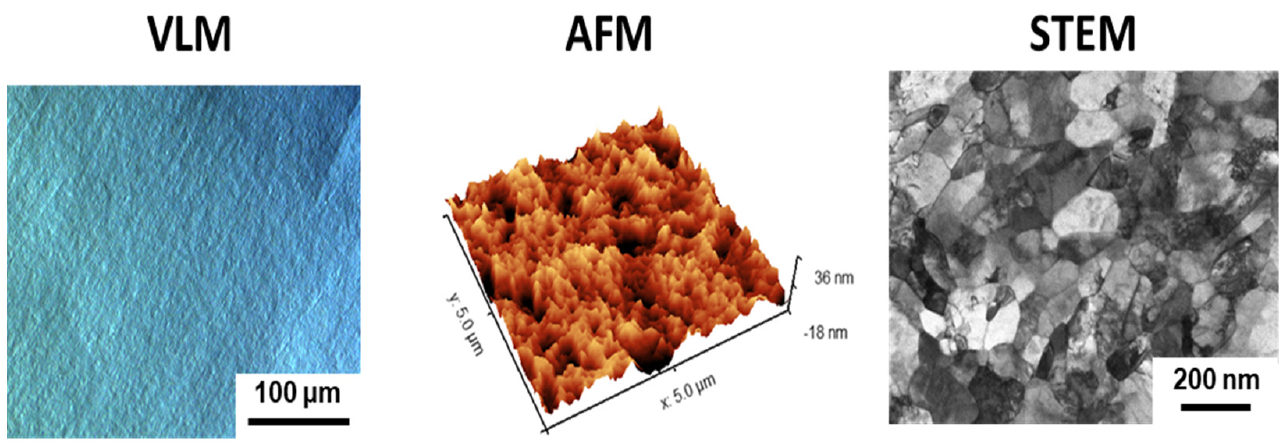
Figure 1. Evaluation of nanostructured Ti surface topography (VLM micrograph and AFM map) origins from its refined microstructure (STEM image).